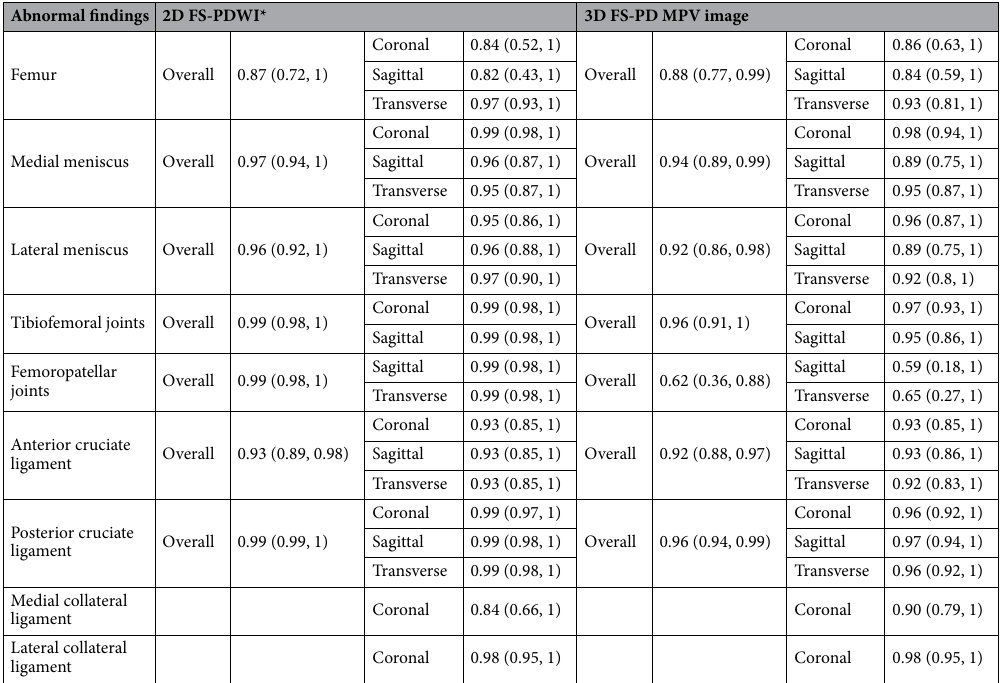
Table 4. Inter-rater reliability coefficients using Gwet’s AC 2 in abnormal findings. 2D FS-PDWI indicates 2-dimensional fat saturated-proton density weighted image; 3D FS-PD MPV, 3-dimensional fat